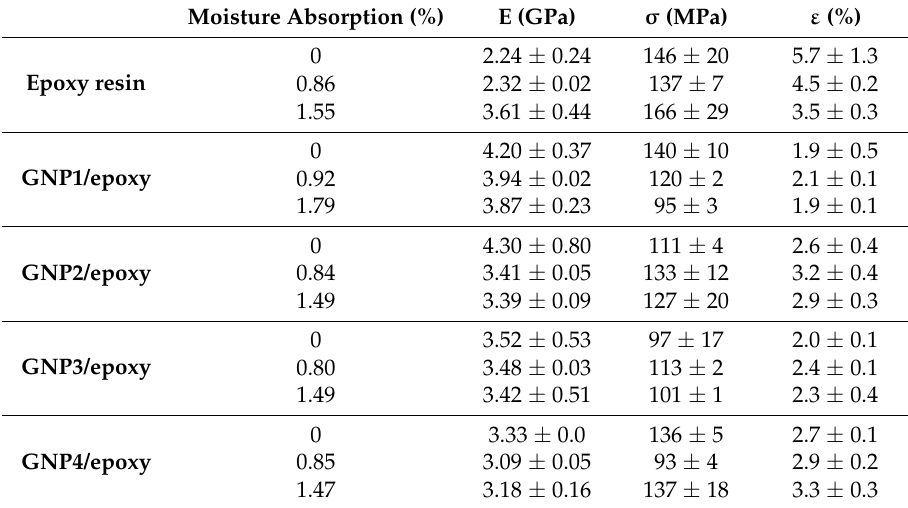
Table 3. Mechanical properties of neat epoxy resin and composites at different aging